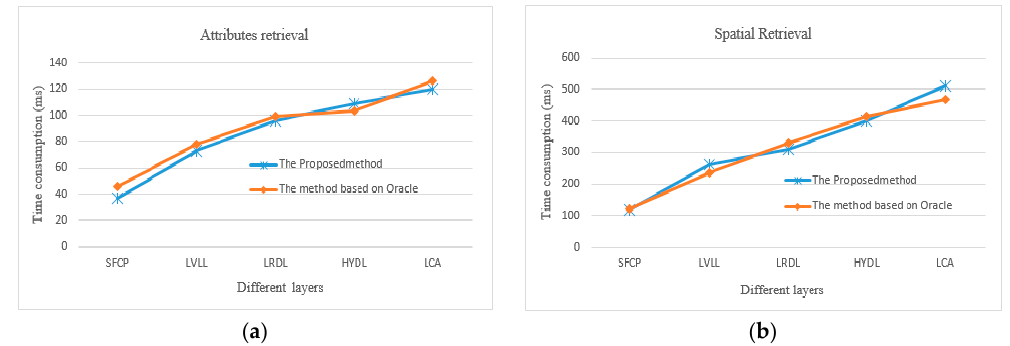
Figure 13. ( a ) Time comparison of attributes retrieval; ( b ) time comparison of spatial retrieval.